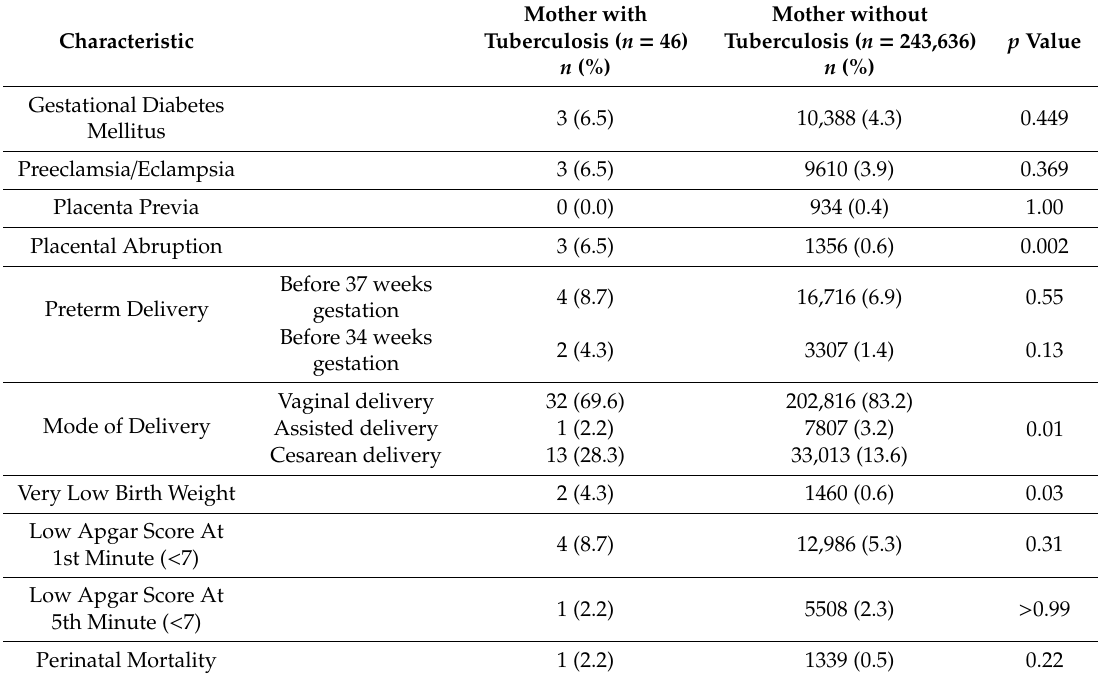
Table 2. The association between maternal tuberculosis and adverse perinatal outcome; univariable analysis.